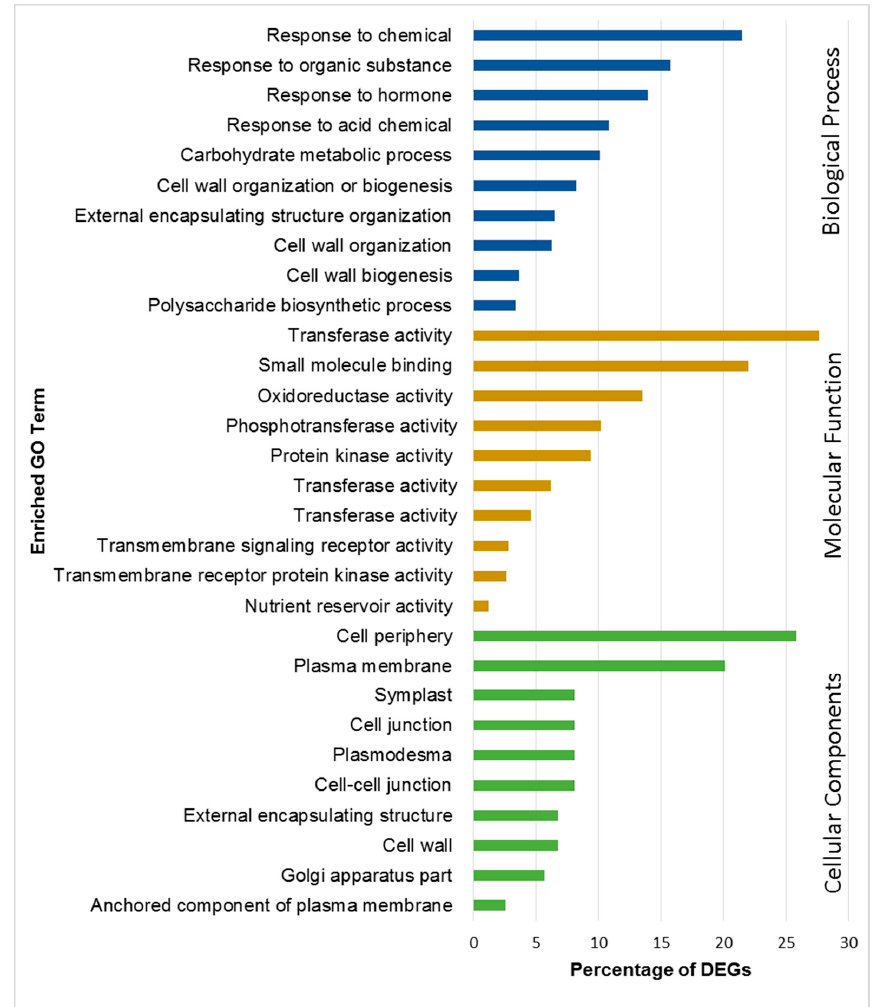
Figure 2. Top 10 gene ontology terms under biological process, molecular function and cellular components enriched among the DEGs upregulated in PI 257145 versus PI 224448.